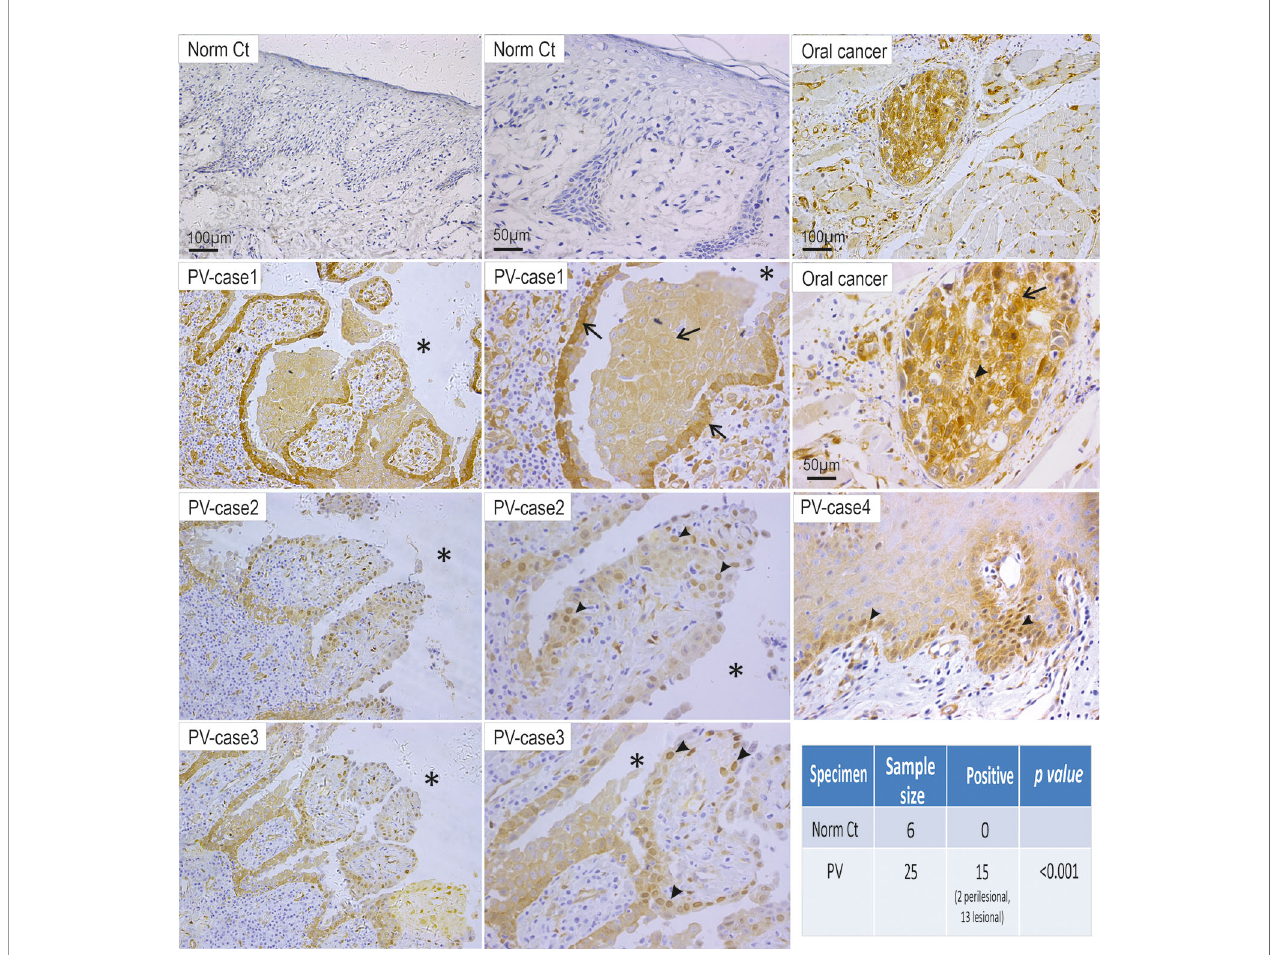
FIGURE 1 | Elevated YAP steady state protein levels are detected in the oral mucosa of patients with PV. Twenty- fi ve PV cases and six healthy individual controls were analyzed by immunohistochemistry for YAP. Positivity of YAP staining with increased nuclear (arrowheads) and cytoplasmic (arrows) signals was detected in cells surrounding the blisters (13 cases) and perilesional regions (2 cases) in 15 PV patients, whereas the healthy control samples (Norm Ct) showed little or no staining. Asterisks indicate the locations of blisters. Oral cancer was used as a positive control here that showed increased YAP in both the nuclei and cytoplasm. Chi-Square statistic was used to obtain the p-value for comparison between PV and healthy control groups, shown in the table. Scale bars are displayed in the